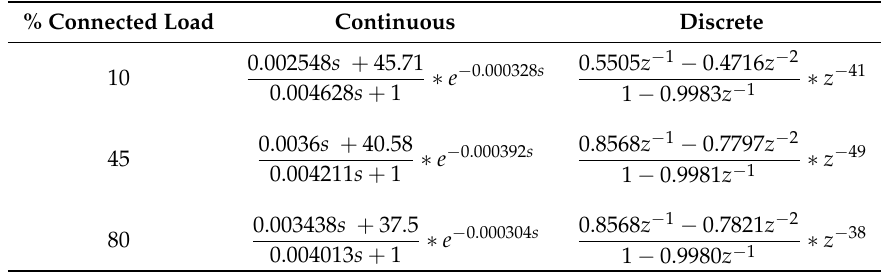
Table 1. Transfer functions of the DC-HV DC converter for a connected load of 10%, 45% and